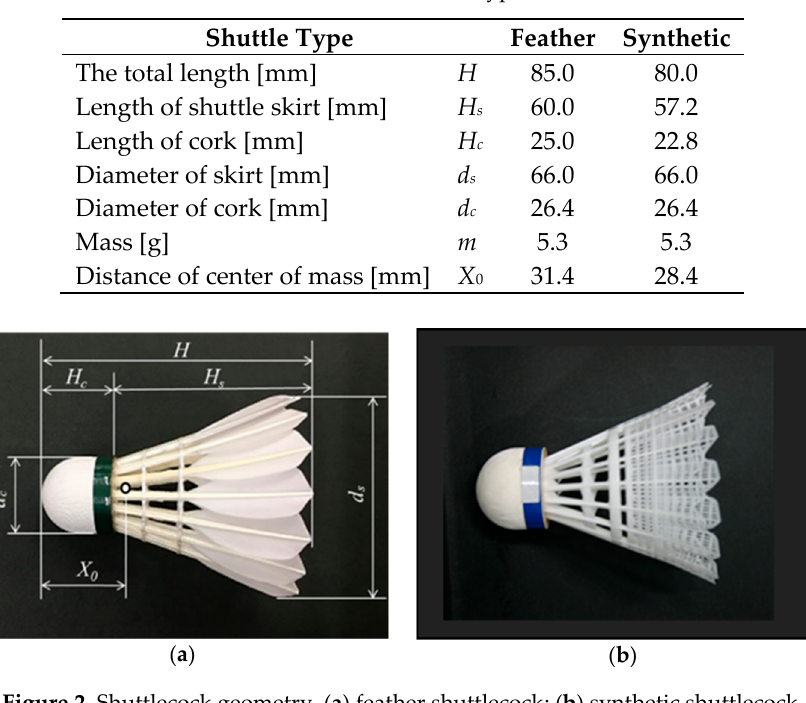
Figure 2. Shuttlecock geometry, ( a ) feather shuttlecock; ( b ) synthetic